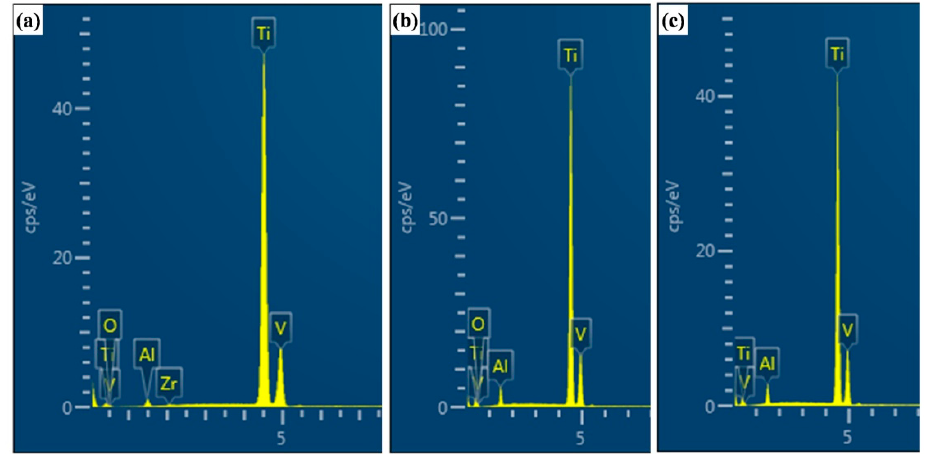
Figure 7. EDS results of a typical area on the worn surface in Figure 6.